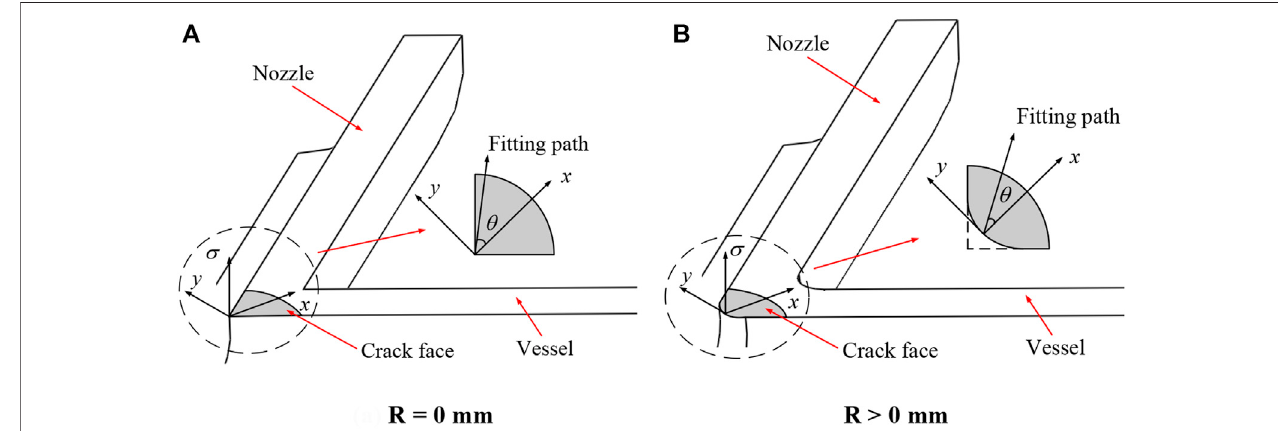
FIGURE 3 | Stress fi tting